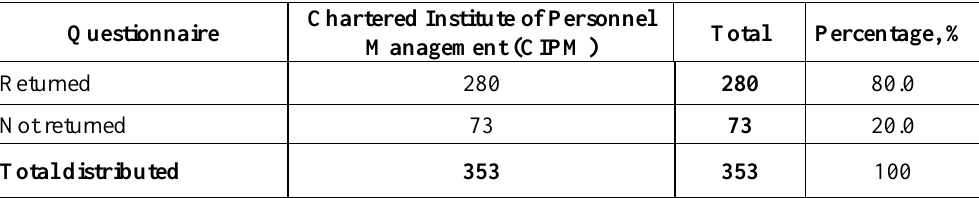
Table 1. Analysis of Response Rate